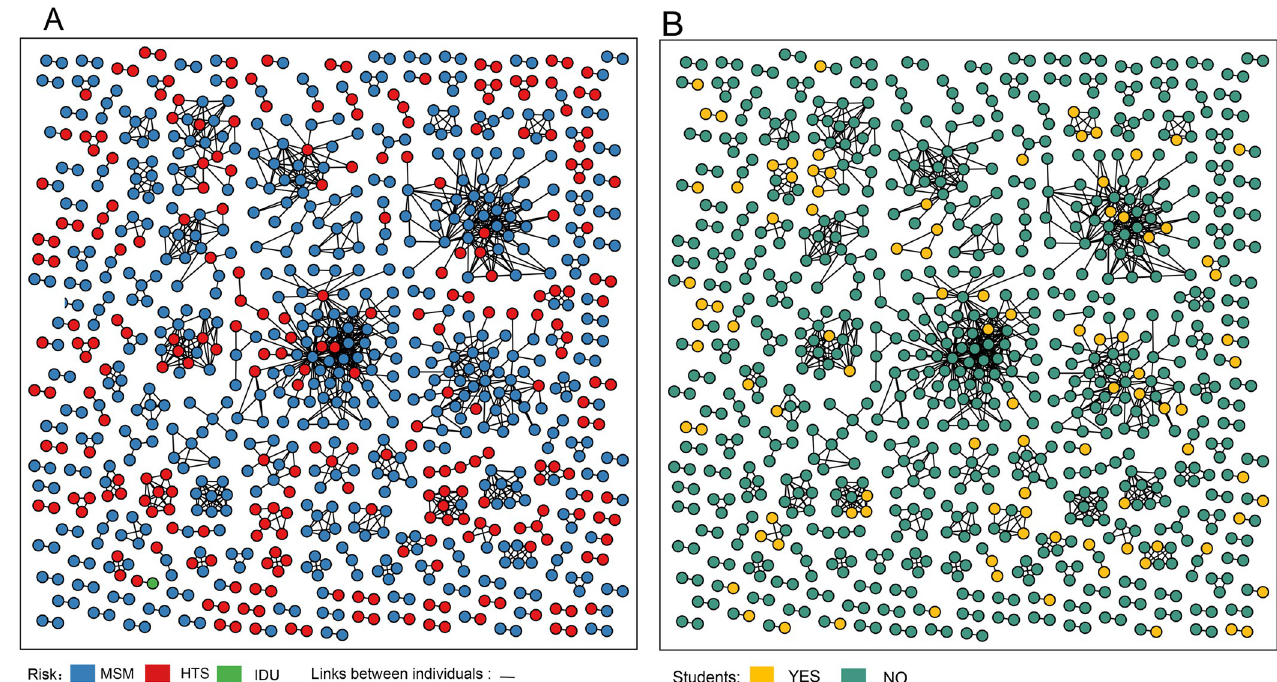
Fig 3. HIV transmission network. HIV transmission clustering in Zhejiang by risk group (A) and student status (B). Edges indicate genetic linkage ( < optimal GD threshold).